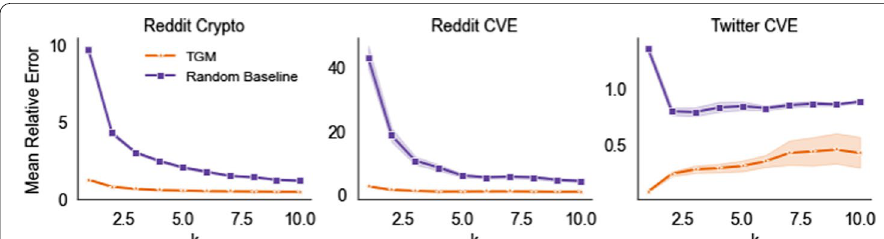
Fig. 6 Mean Relative Error of size prediction versus number of nodes k in the given initial tree. Shaded areas in this and the following plots indicate 95% confidence intervals